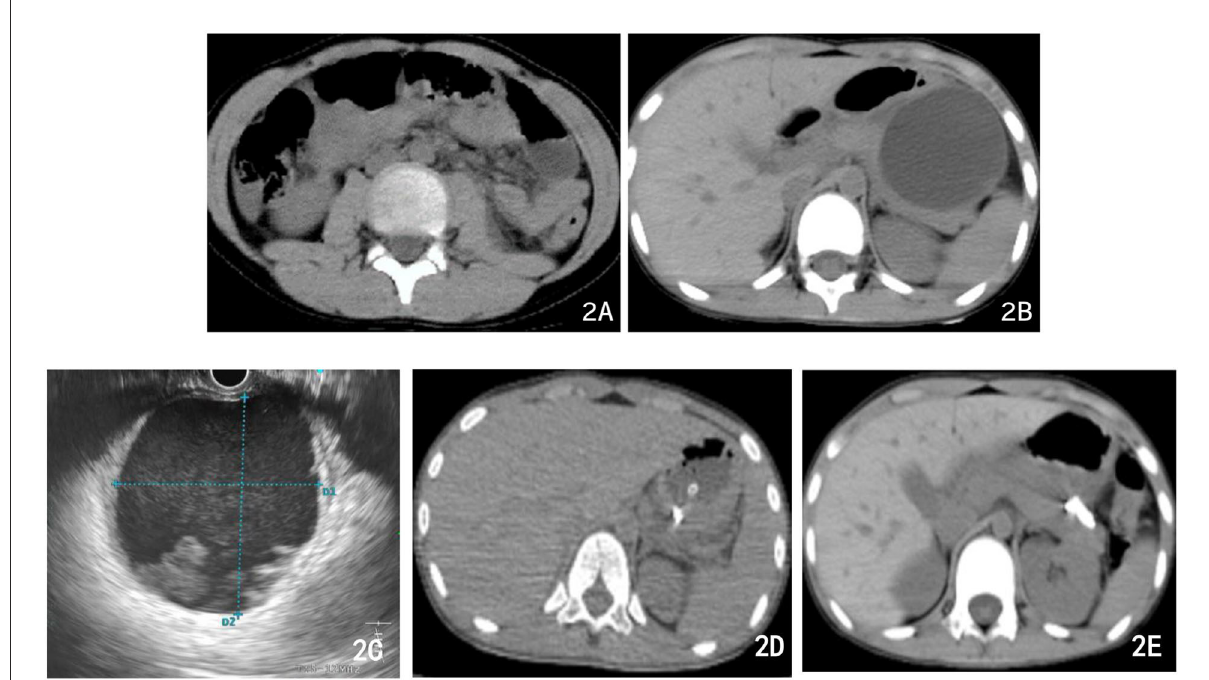
FIGURE2 Abdominal CT imaging of different therapeutic periods. (A) First abdominal CT after bicycle accident: the tail of the pancreas was thickened, lumpy high-density shadows near the tail of the pancreas, and patchy isodensity shadows around (the possibility of hematocele and exudation). (B) Abdominal CT 3 weeks later: PPC formation with a maximum cross size of ∼ 6.5cm × 6.8cm. (C) During the operation, the ultrasound endoscope found that the echo-free zone existed in the area, with a slightly high echo in the shape of a mass, a weak echo in the shape of a floating dot, and no blood flow signal in the area. (D) Postoperative abdominal CT: PPC in the tail of the pancreas was significantly reduced, with tubular shadows and little air accumulation in the corresponding area. (E) Abdominal CT 10 days after the previous one (D) multiple strip-shaped extremely high-density shadows in the tail of the pancreas and a few surrounding strips with slightly lower density.